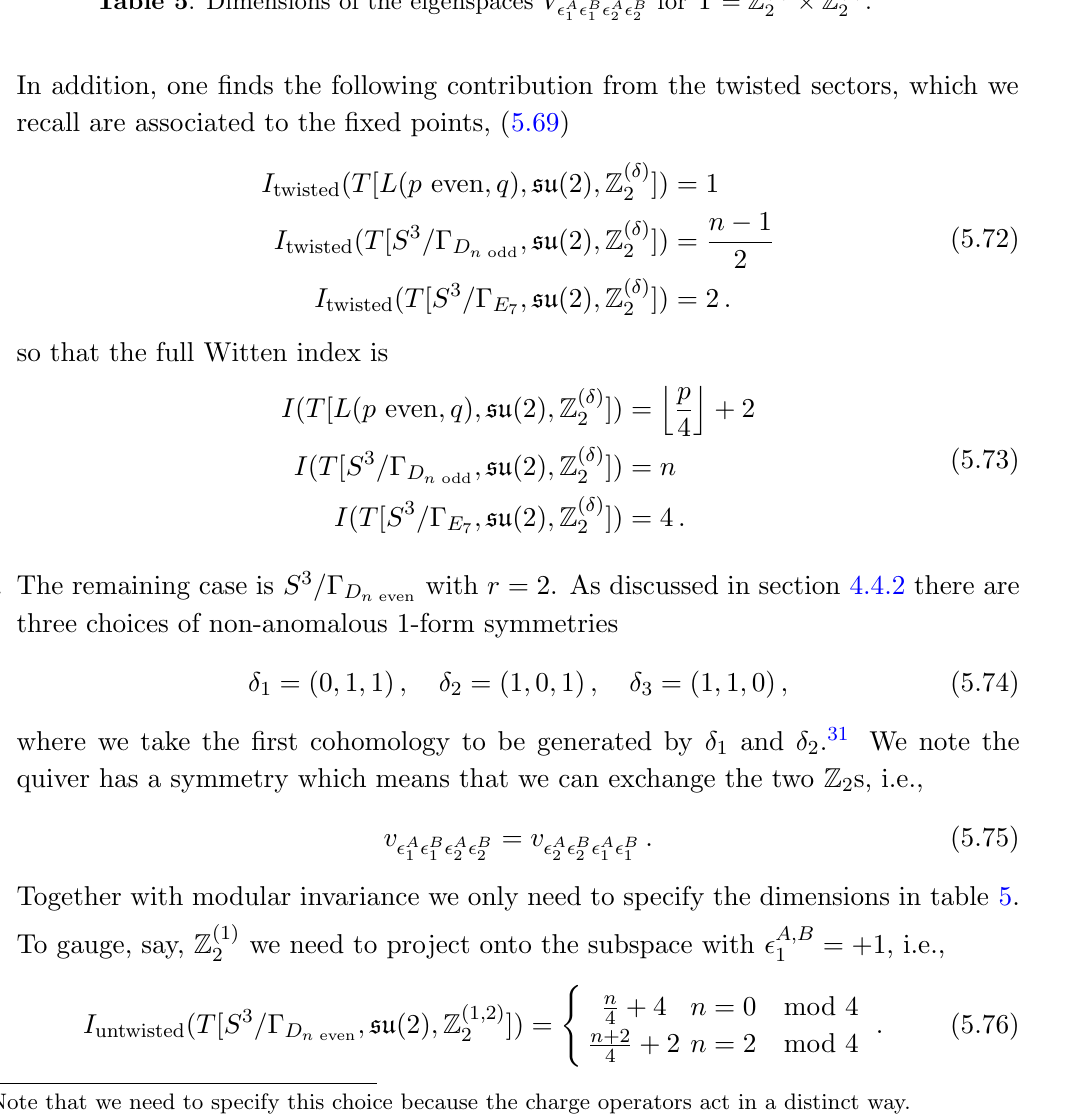
Table 5 . Dimensions of the eigenspaces V